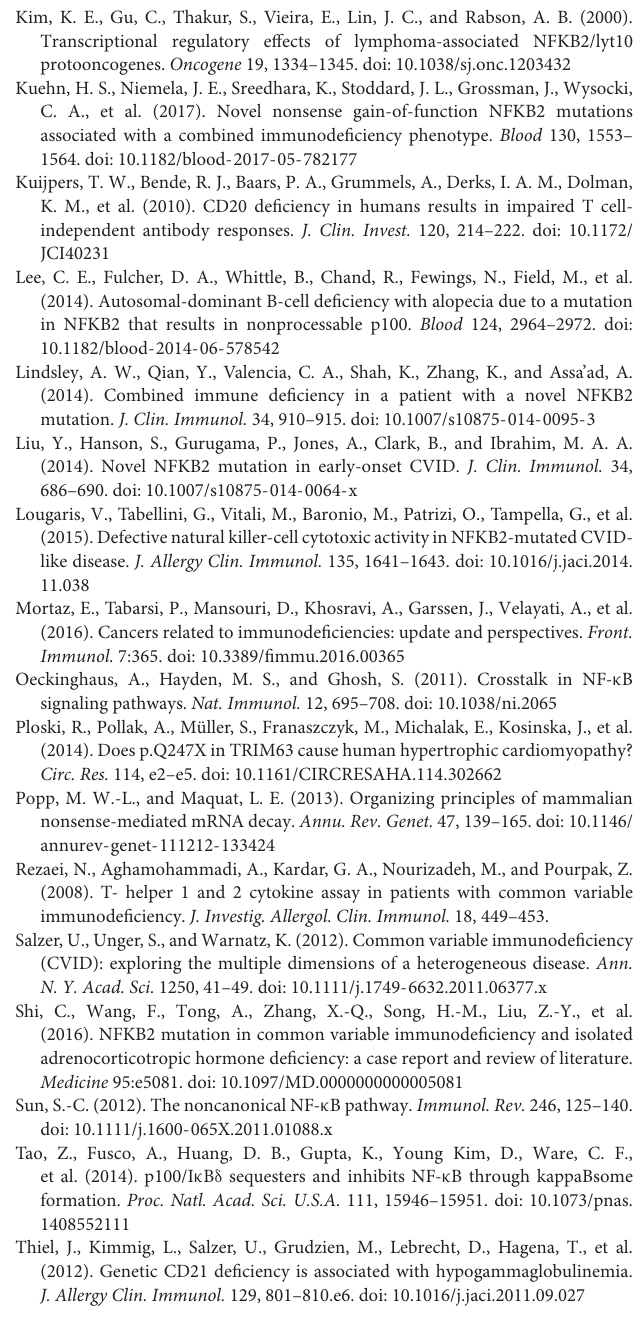
FIGURE S2 | Expression of mutated NFKB2 allele. (A) Raw data of high resolution melt analysis. Real-time PCR was performed in triplicates and each curve corresponds to one sample (one well in the 96-well real-time PCR plate). Black curves represents control subjects, red curves represents subjects with c.1831C > T mutation. (B) Real-time PCR analysis of NFKB2 expression in leukocytes collected from 10 control patients and 3 carriers of nonsense mutation c.1831C > T (p.Arg611 ∗ ). FIGURE S3 | Densitometry analysis. Amount of p100 (A) and p52 (B) proteins were evaluated by western blot and next quantified by densitometric